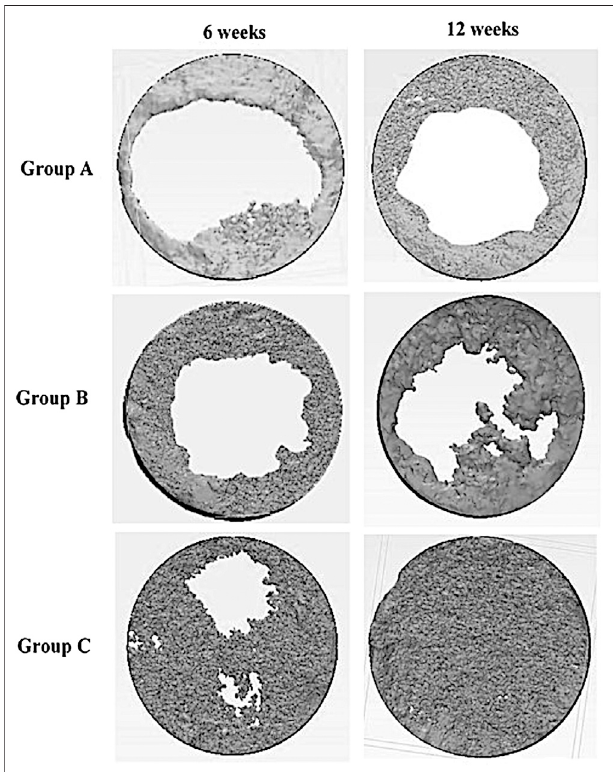
FIGURE 5 | Construction of a 3D model of defects in rabbits in different groups (groupA(control),group B(chitosangel),groupC(OPG-chitosangel)) after treatment at 6 and 12